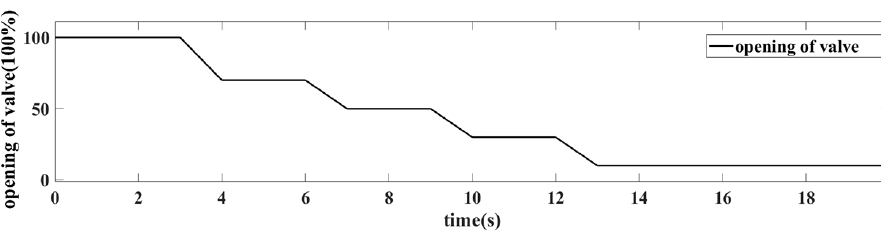
Figure 9. System diagram of the compression system with one throttle valve.